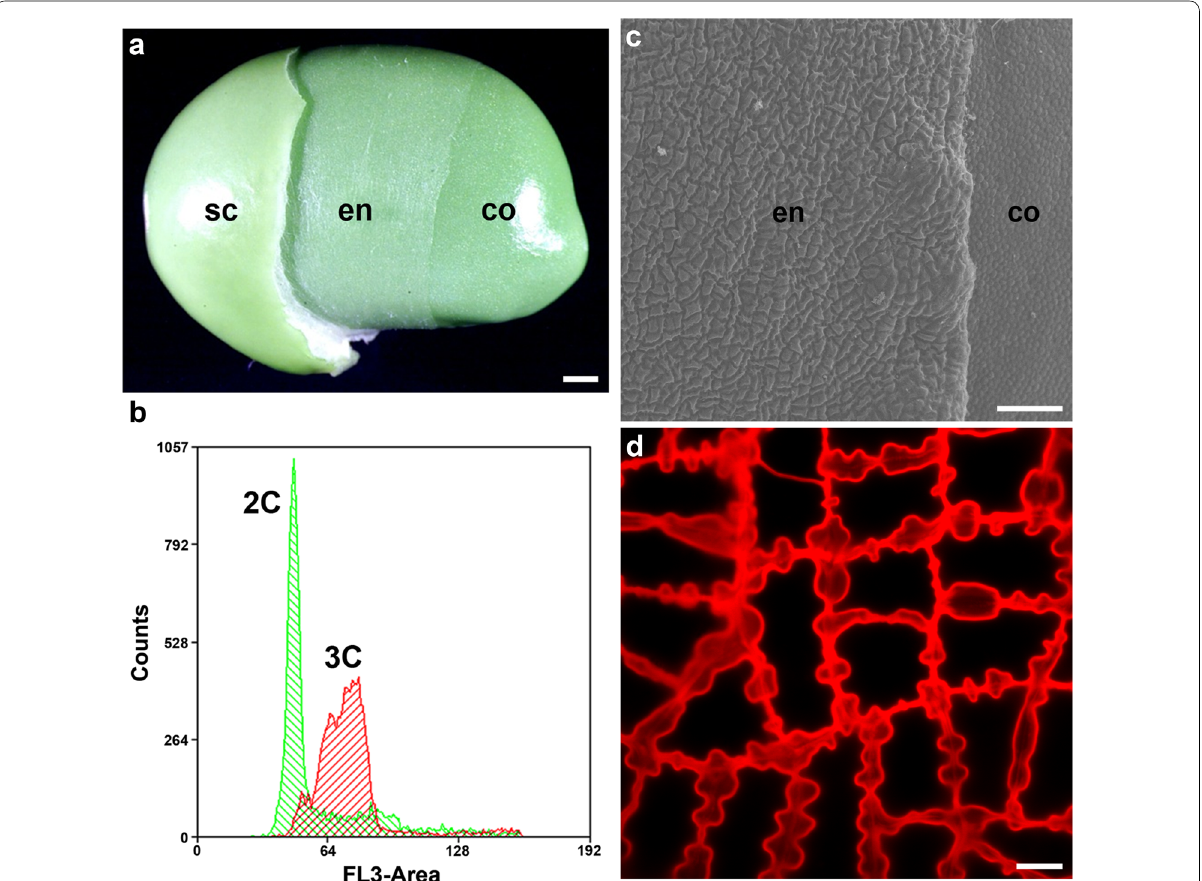
Fig. 1 The structural morphology and ploidy of soybean endosperm. a Photographs of soybean seed. Parts of seed coat (sc) and endosperm (en) were removed. Endosperm is an independent and membrane‑like tissue, located between the seed coat and cotyledon (co). b Flow cytometry of fresh leaves (green) from mature plants, and peeled endosperm (red) from soybean seed at 35 days after flowering (DAF). The diploid internal reference produced two peaks (green area), including a major peak with 2DNA quantity and a minor peak corresponding to 4 DNA. The peak of × × the red area corresponds to 3 DNA. c Cryo‑scanning electron microscopy (cryo‑SEM) of soybean endosperm and cotyledon epidermis cells at 35 × DAF. Cell wall ingrowth of soybean endosperm is identified in endosperm. d Fluorescence microscopy of propidium iodide‑stained cell wall from soybean endosperm. sc, seed coat; en, endosperm; co, cotyledon. Scale bars 1 mm for a , 100 μm for c and 10 μm for =